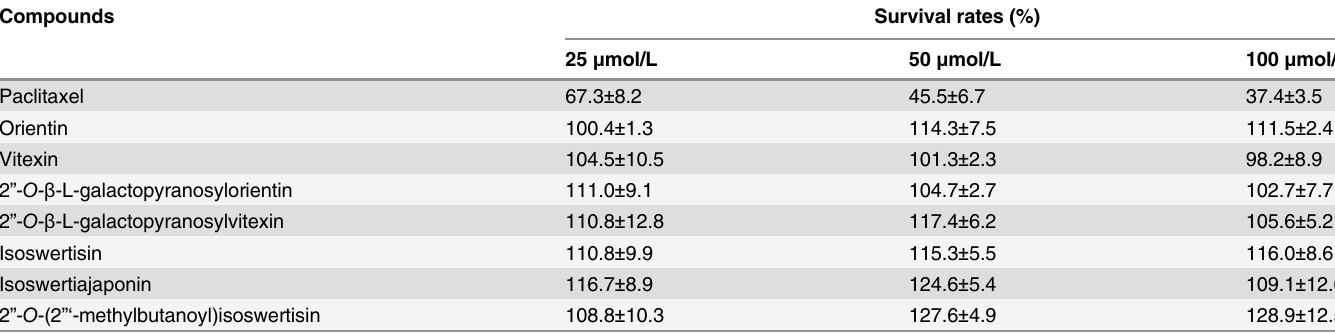
Table 1. Survival rates of Caco-2 cells treated with the seven fl avonoids and paclitaxel. Compounds